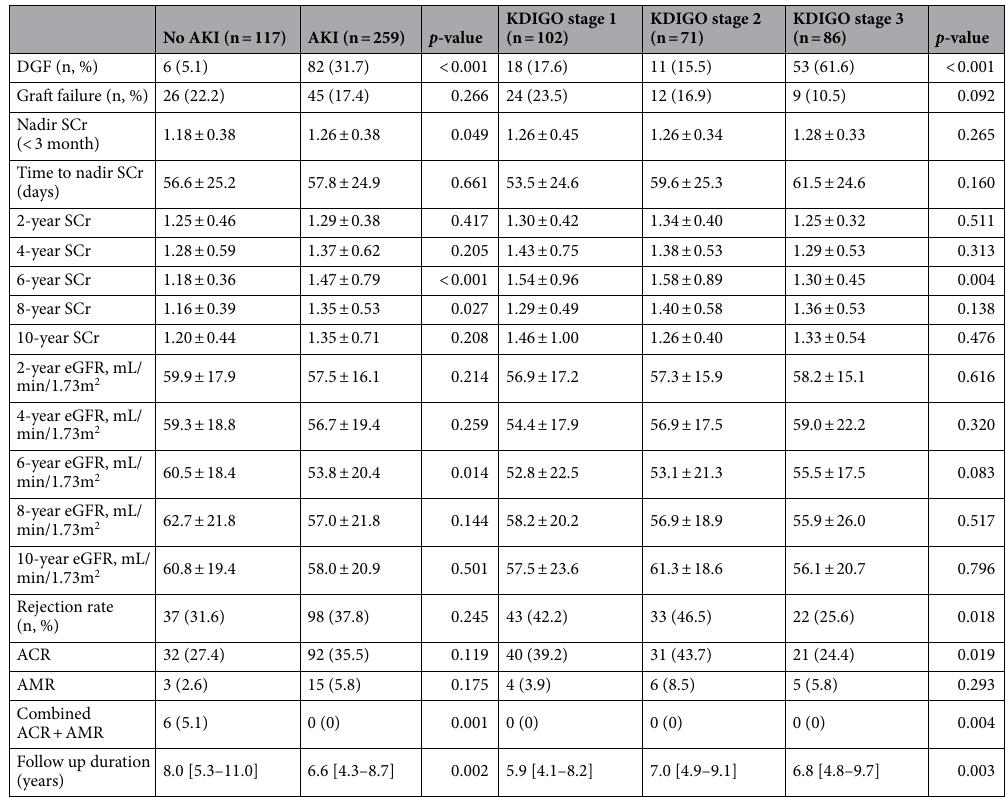
Table 3. Clinical outcomes. Continuous variables given as mean ± SD or as median [P25-P75]. AKI acute kidney injury, KDIGO kidney disease: improving global outcomes, DGF delayed graft function, SCr serum creatinine, eGFR estimated glomerular filtration rate, ACR acute cellular rejection, AMR antibody mediated